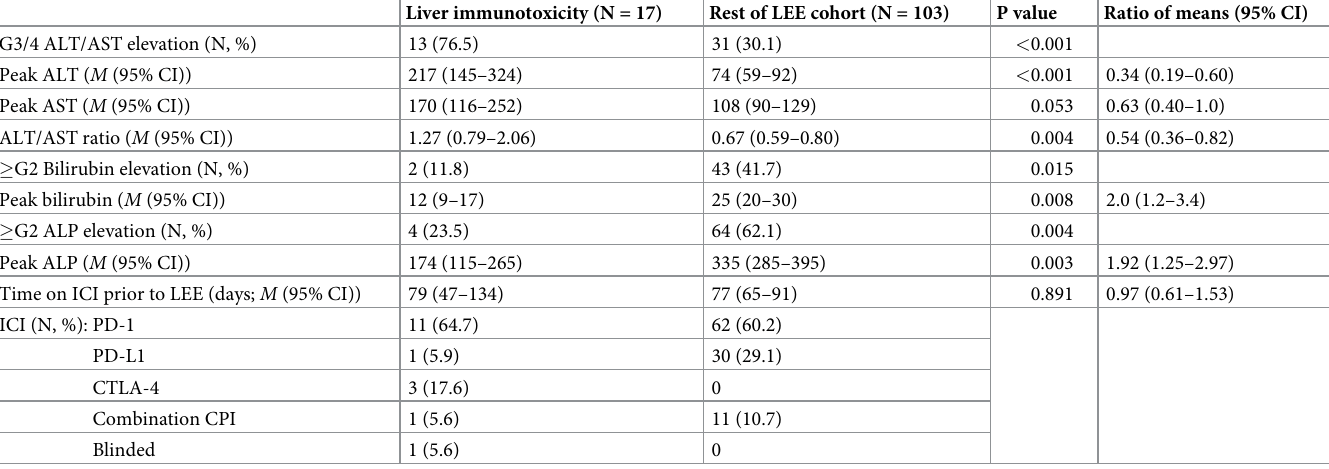
of patients with immunotoxicity vs 15.9% of patients without, p = 0.01), although the duration of current ICI therapy, and the interval from prior ICI therapy were not associated with